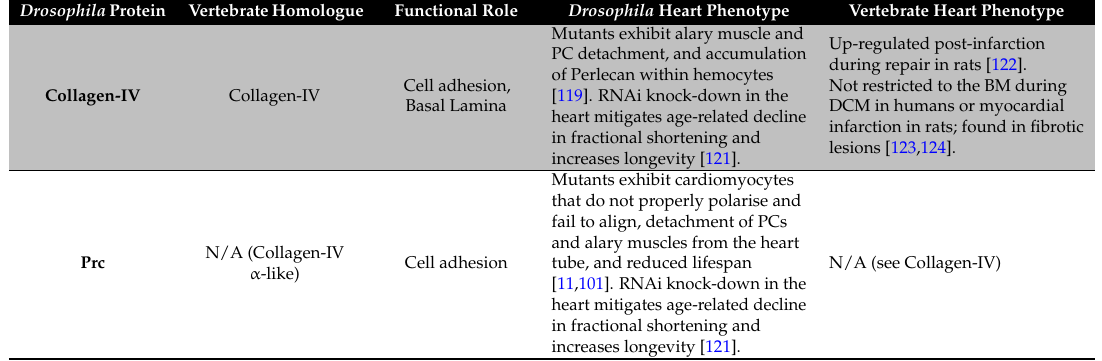
Table 1. Structural proteins of the